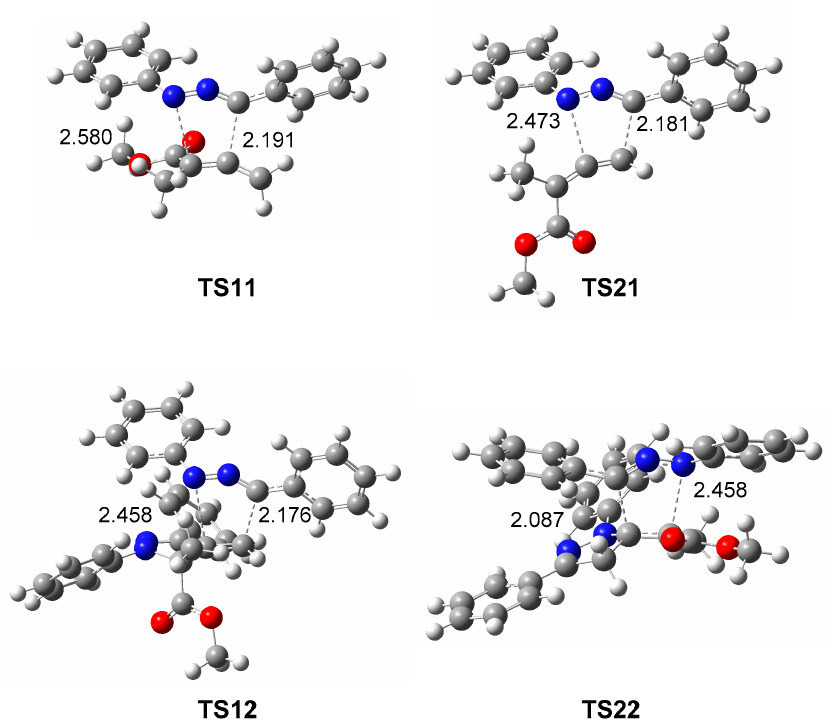
Figure 4. MPWB1K/6-311G(d) geometries in DCM of the TSs involved in the domino reaction of diphenyl NI 1 with allenoate 4 yielding spirobipyrazoline 5 . Distances are given in angstroms, Å.